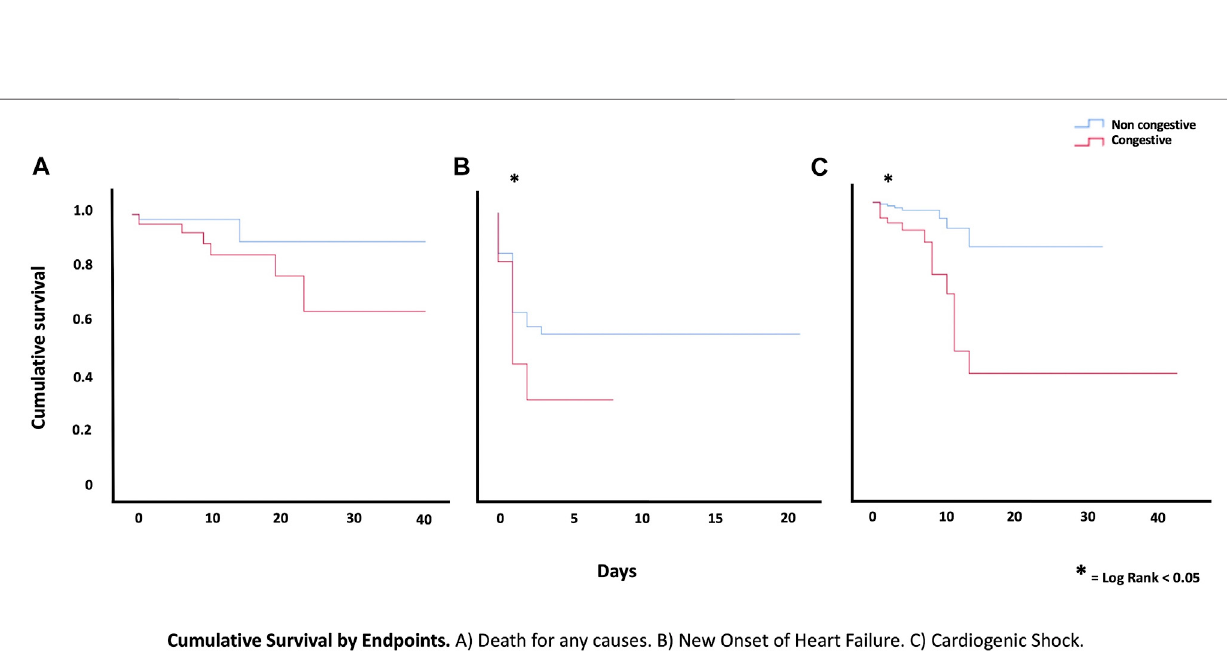
Frontiers in Physiology |